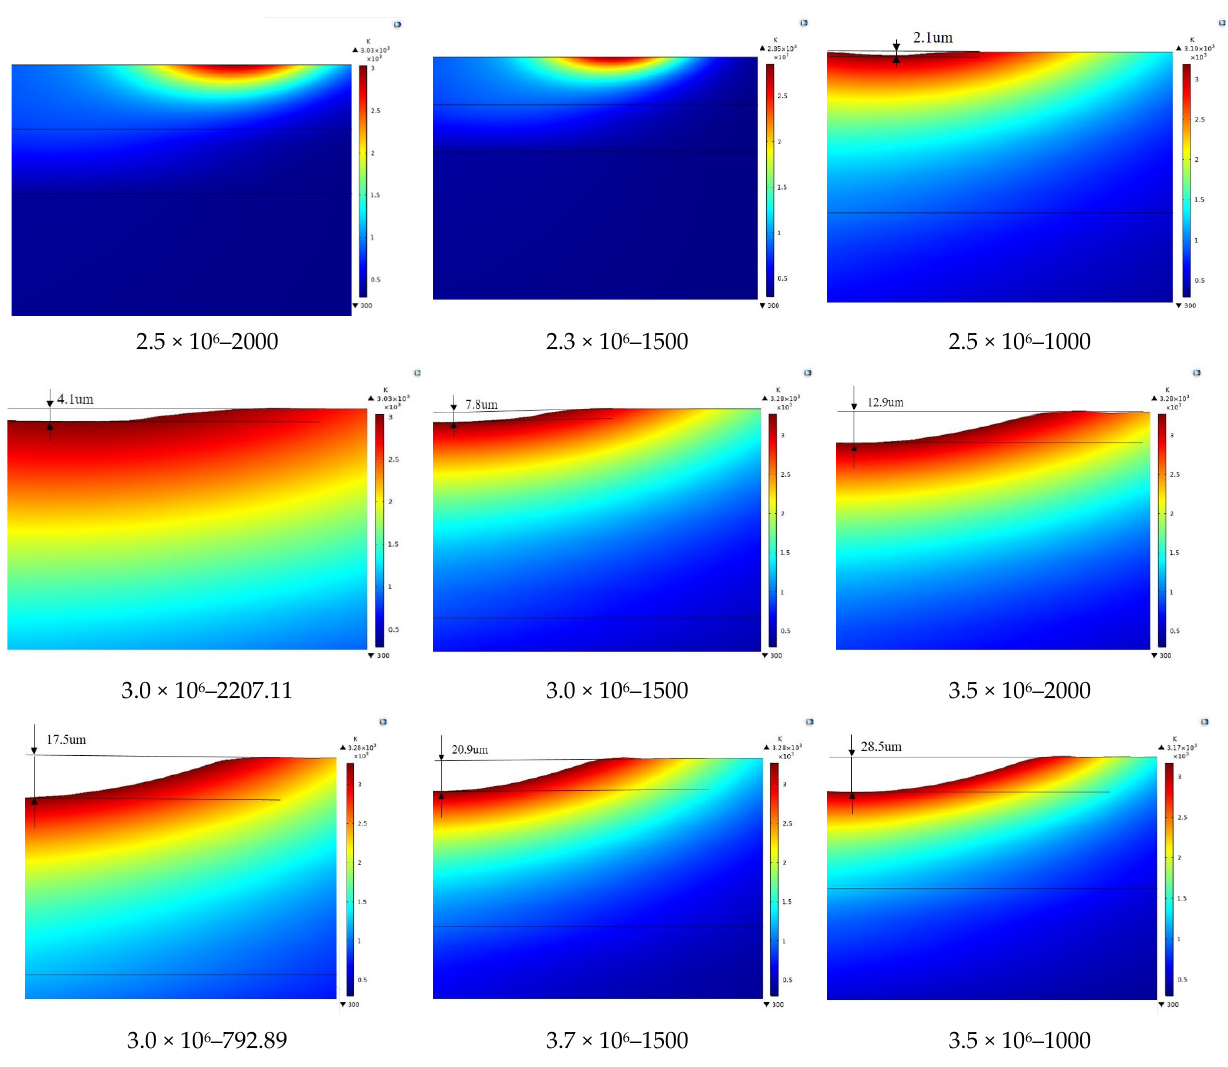
Figure 6. Ablation depth under different laser parameters. Table 4. Estimated regression coefficient of ablation